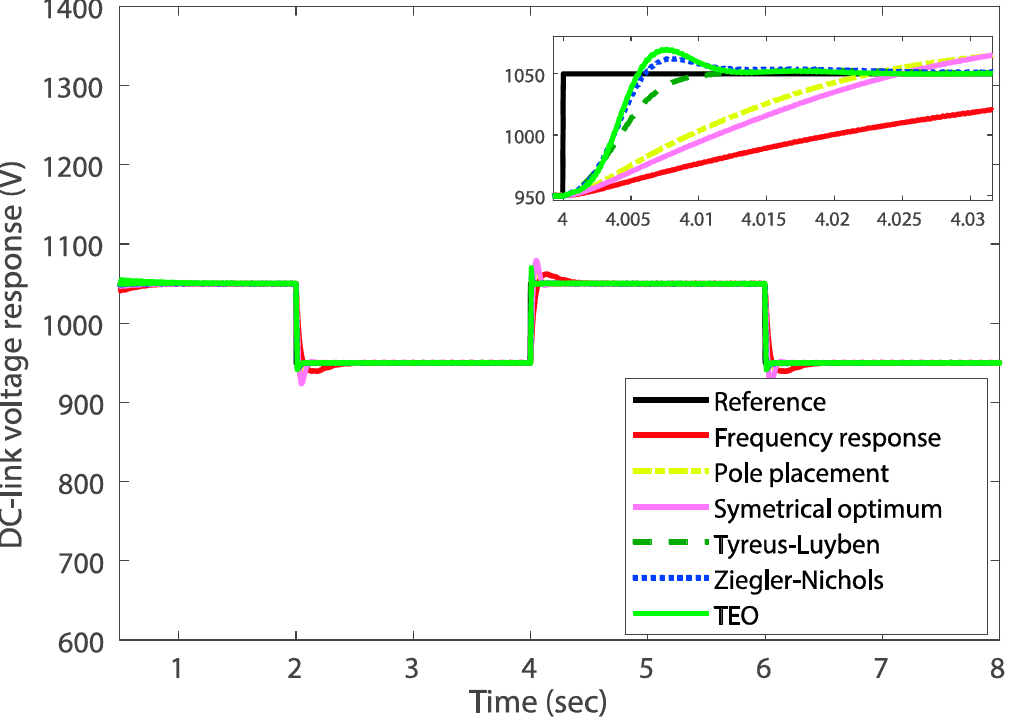
Figure 9. DC-link voltage responses against step changes for different-tuned PI controllers .